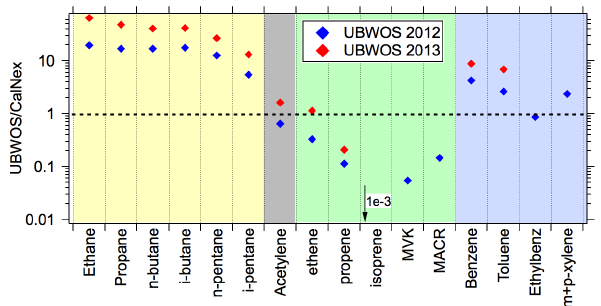
Figure 3. Ratios of average concentrations of various VOCs in UB- WOS 2012 and UBWOS 2013 relative to CalNex. The dashed line indicates a ratio of unity.